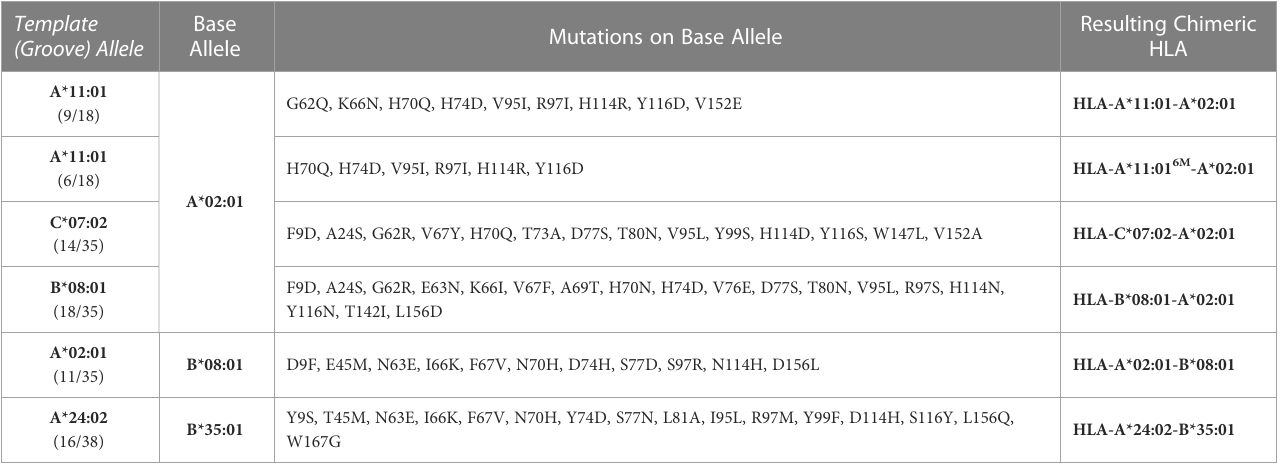
TABLE 1 Summary of amino acid substitutions introduced in the sequence of a base allele to derive chimeric HLAs. Template Base (Groove) Allele